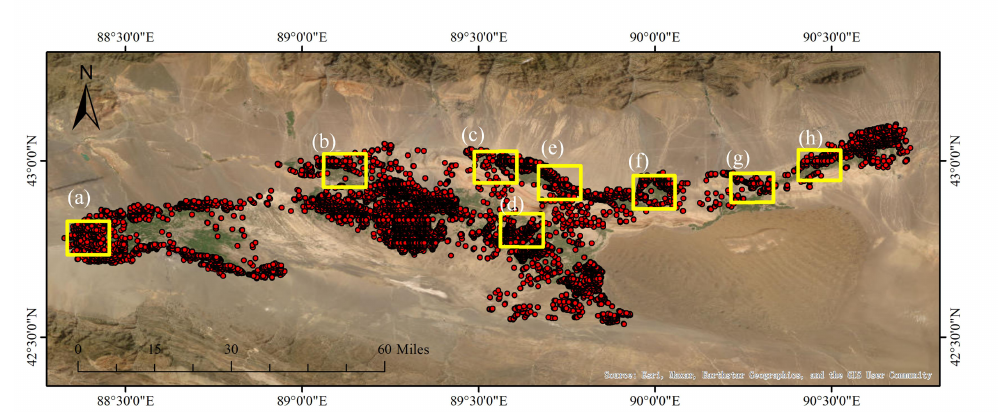
Figure 13. A karez map of the Turpan Basin, with a red dot representing the location of a karez shaft in 2020. The map also features eight yellow rectangular boxes (a)–(h). The local magnified views of (a)–(h) are shown in Figure 14. The base map used is the ArcGIS online imagery World_Imagery.